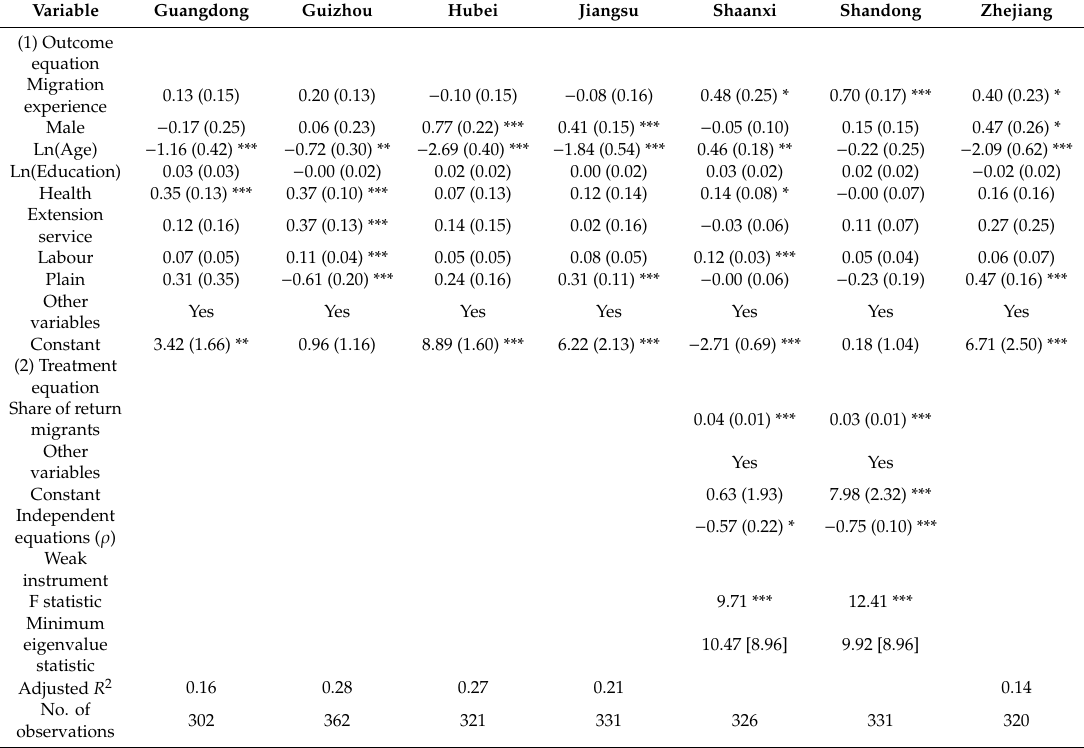
Table 6. The e ff ects of rural–urban migration experience on arable land use by